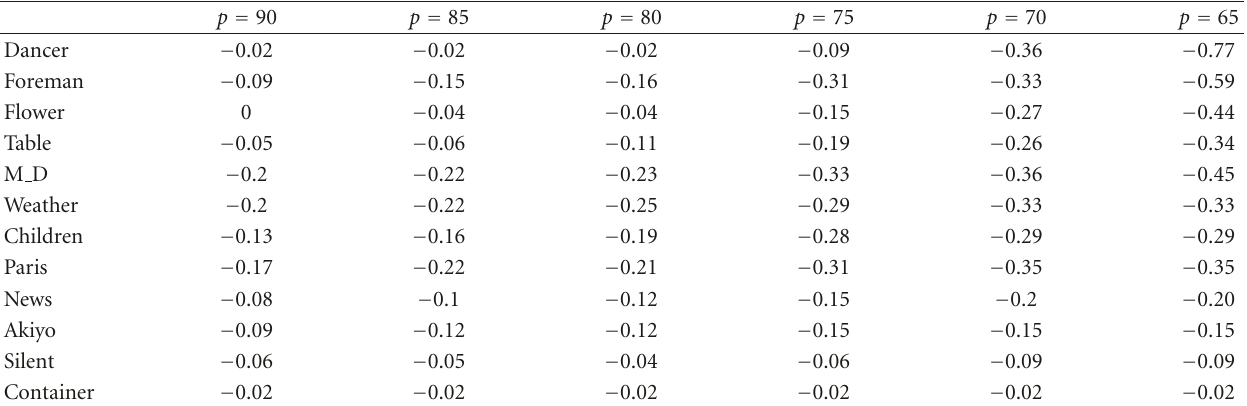
Table 3: Analysis of quality degradation using three adaptive subsample rate decisions.